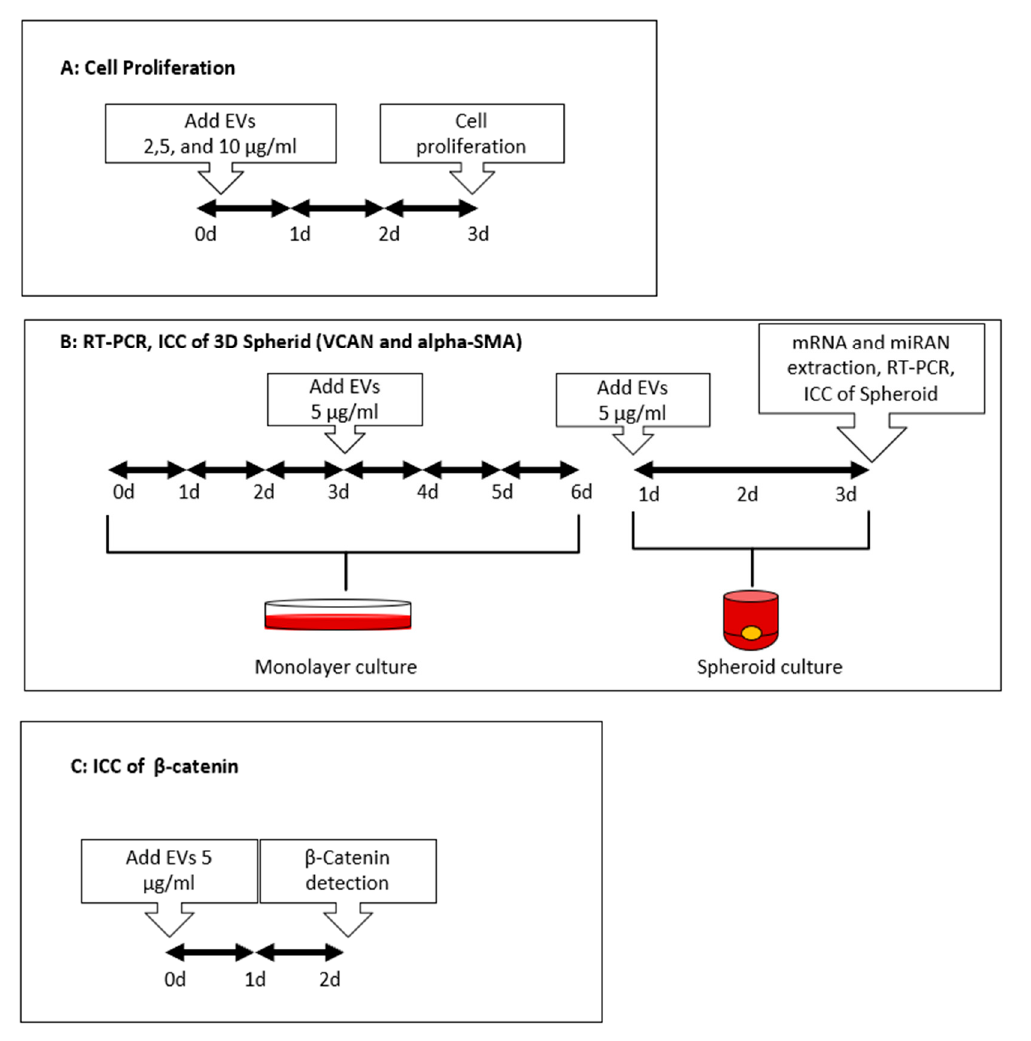
Scheme 1. The schematic figure represents experimental design. Schem e 1. The schematic figure represents experimental design. The EV uptake assay was performed to ensure that the EVs were biologically active. EV uptake by ASCs was evaluated by incubating the cells with DPC-EVs for 48 h and then staining them with anti-CD63 antibodies to detect the incorporated